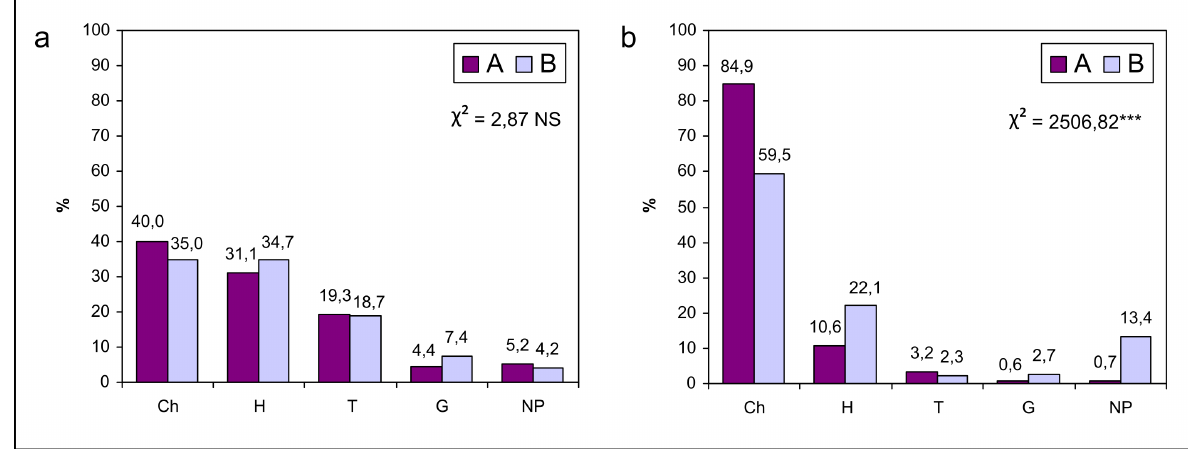
Figure 4. Biological spectra weighted by frequency (a) and cover index (b) of the Satureja montana garrigues in Ionian Arc (A) and in Alta Murgia (B). *** = p<0,001; NS = Not significant.